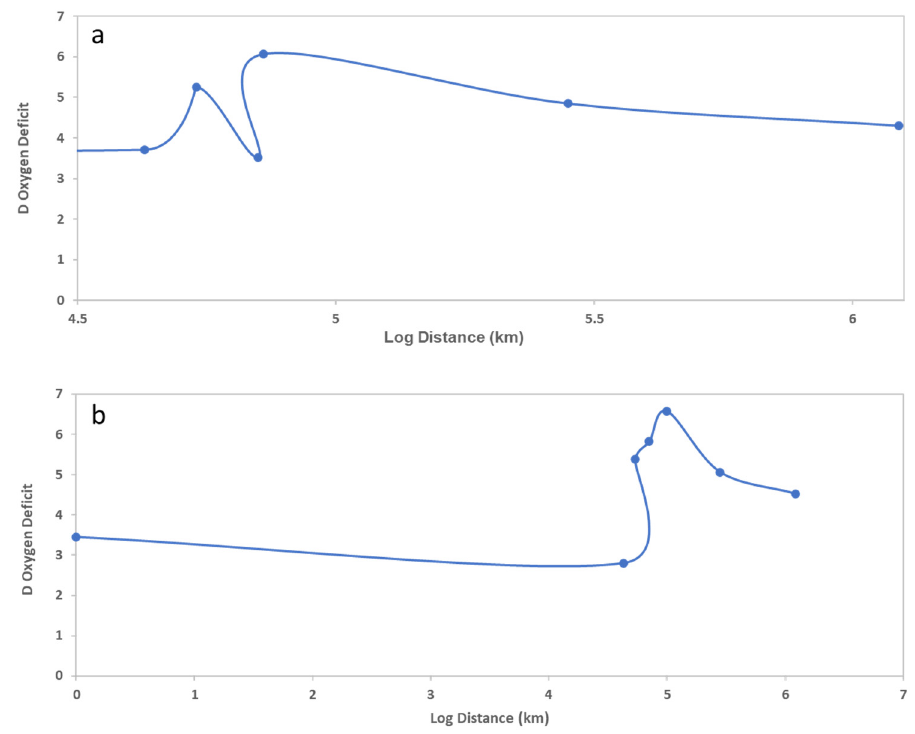
Figure 4. Variation of oxygen deficit with distance: ( a ) for the year 2020, ( b ) for the year 2021.